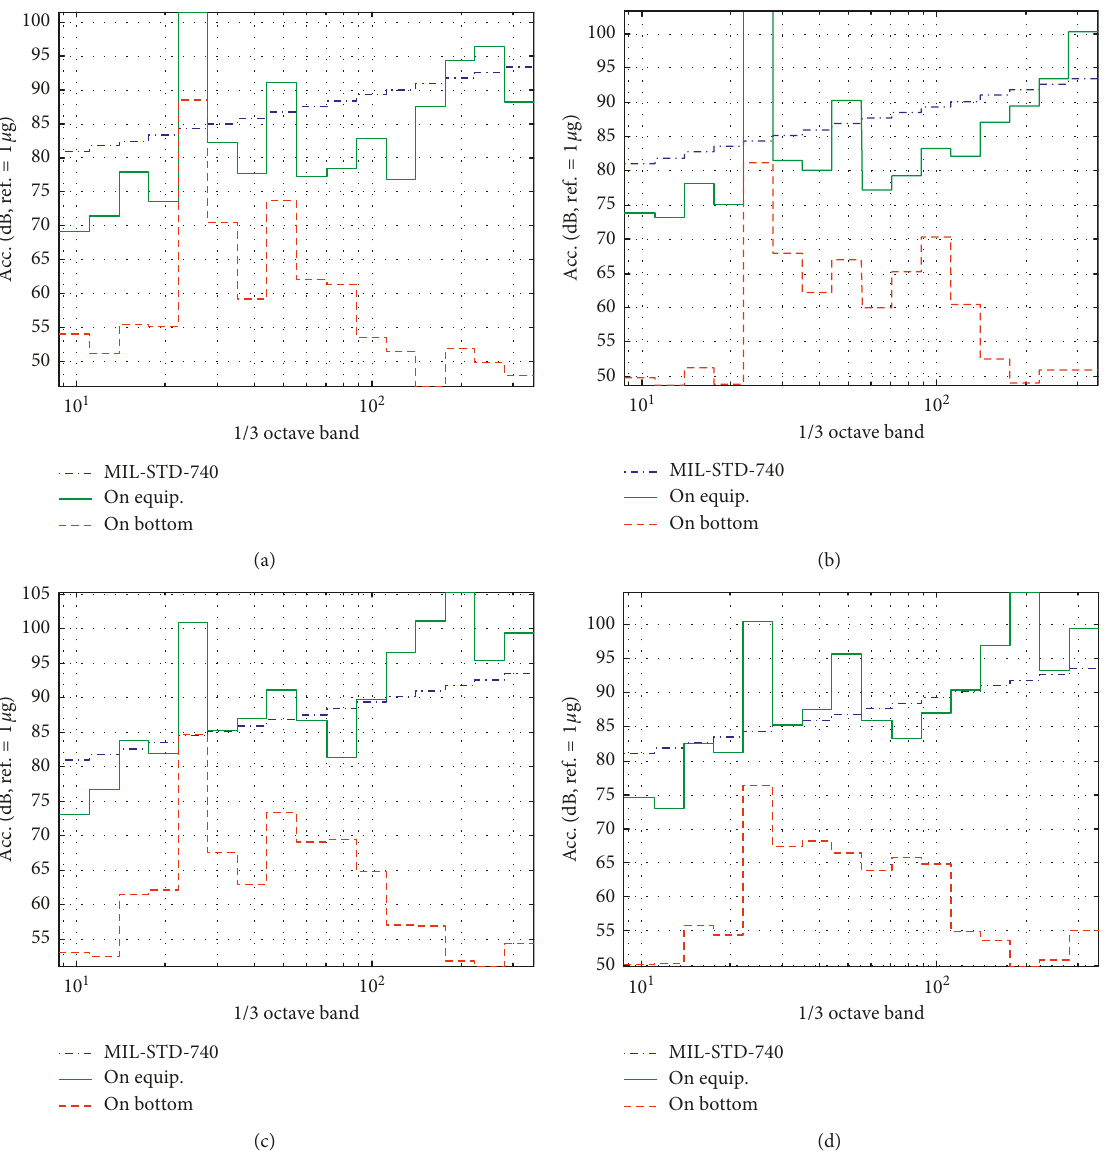
Figure 2: Acceleration signals at supported location: 1/3 octave scale. (a) Location 1. (b) Location 2. (c) Location 3. (d) Location 4.